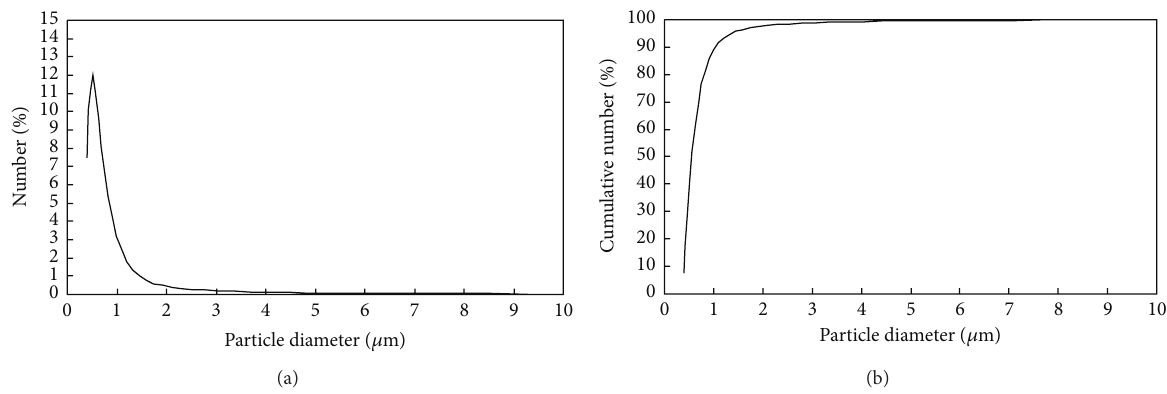
2 , 𝑟 2 , and 𝑟 2 are correlation coefficients by means of fitting the experimental data to Langmuir, Freundlich, and Dubinin-Radushkevich isotherms, a 𝑟 L F D respectively. b The ranges of the equilibrium concentrations of the experiments performed are 0.61–92.9, 0.82–91.1, and 0.52–91.3mgL −1 for pH respectively. c The final pH values of solutions at the end of experiments were about 7.36–7.87, 6.9–8.05, and 7.42–8.39 for pH